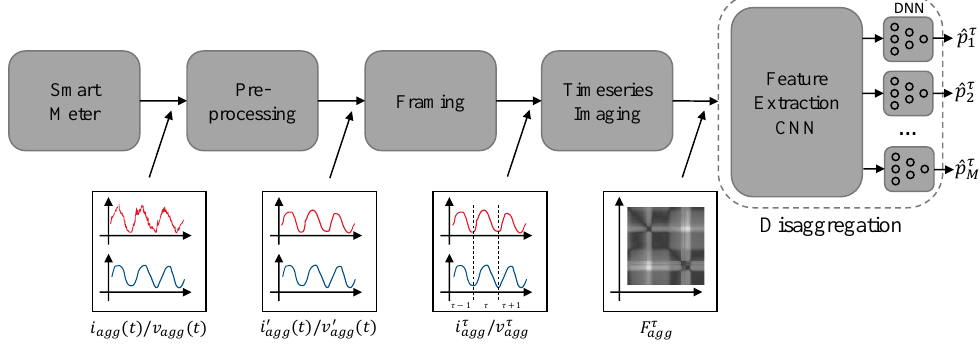
Figure 2. Non-Intrusive Load-Monitoring architecture using time series imaging for high-frequency data inputs.